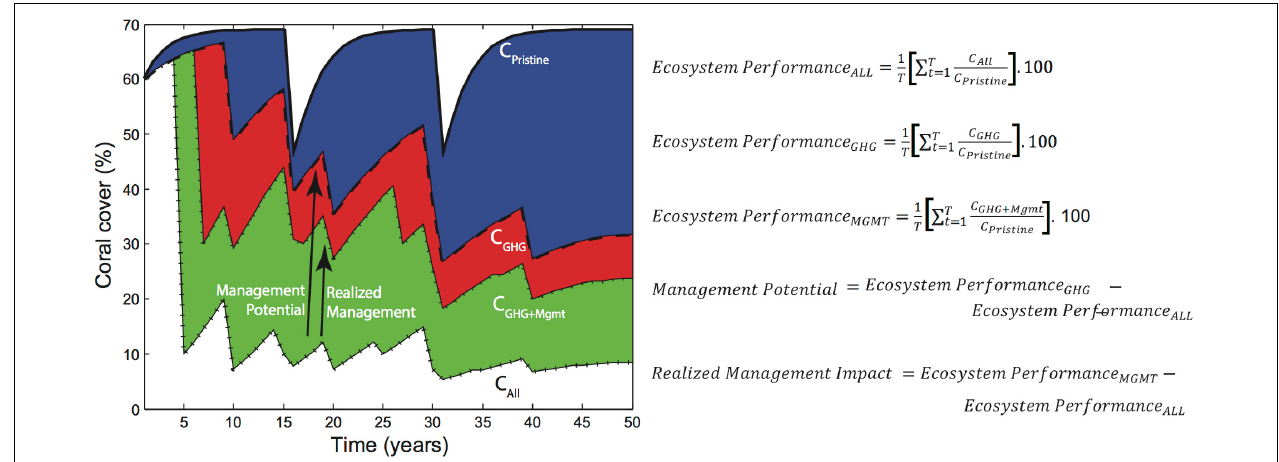
FIGURE 4 | Use of Reef Performance metrics with modeled projections of reef futures with various levels of stressors (adapted from Mumby and Anthony, 2015). Results integrated over T time steps, t .